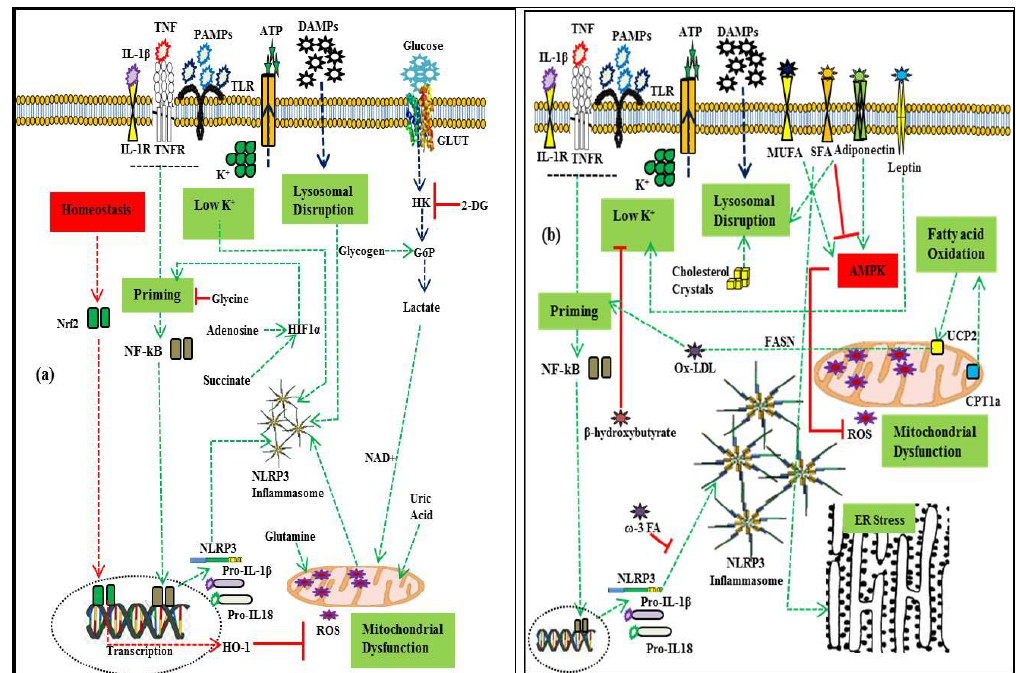
Figure 2. Metabolic regulation of NLRP3 inflammasome activation. ( a ): Regulation by glycolytic flux and amino acid metabolism. As a part of homeostatic regulation, the priming signal activates nuclear factor erythroid 2-related factor 2 (Nrf2), which promotes heme-oxygenase-1 (HO-1), mitigating the effect of mtROS. Increased production of succinate enhances the transcription of pro- IL1β through hypoxia -inducible factor (HIF- 1α). Glycolytic flux promotes inflammasome activation which is inhibited by 2-deoxy-D-glucose (2-DG). Glycine enhances Nrf2-mediated mitigation of inflammasome activity. Glutamine and uric acid enhance it through mtROS. ( b ): Regulation by adipokines and lipid metabolism. The activity of fatty acid synthase (FASN) promotes priming, while omega-3 fatty acid inhibits inflammasome assembly. Saturated fatty acids promote lysosomal disruption and ER stress, while monounsaturated fatty acids promote AMP-activated protein kinase, which in turn inhibits mtROS production. Cholesterol crystals promote inflammasome activation through lysosomal disruption. Similarly, carnitine palmitoyl-transferase 1A (CPT1A) promotes inflammasome activation, and β -hydroxybutyrate inhibits it by suppressing K + efflux. Adiponectin acts as an initiator of AMPK-autophagy inhibition of mtROS and K + efflux, while leptin enhances NLRP3 inflammasome activation. Green lines depict the promotion of inflammasome activation, while red lines depict inhibition.